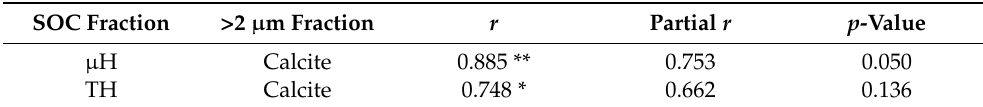
Table 7. Pearson’s correlation coefficients ( r ) for soil organic carbon fractions and the mineral phase, controlling the effects of pH.